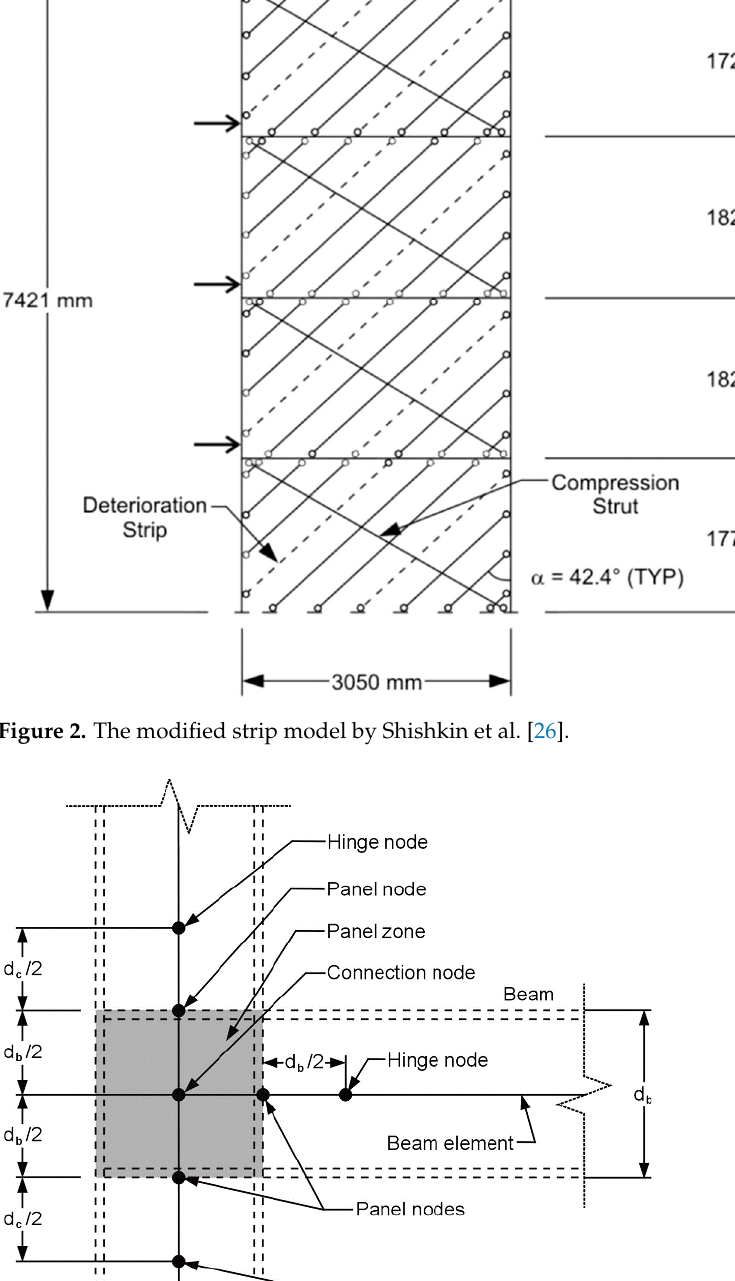
Figure 3. The behavior of plastic hinges followed user-defined moment-versus-rotation relations, assuming the plastic hinge length is equal to the member depth.